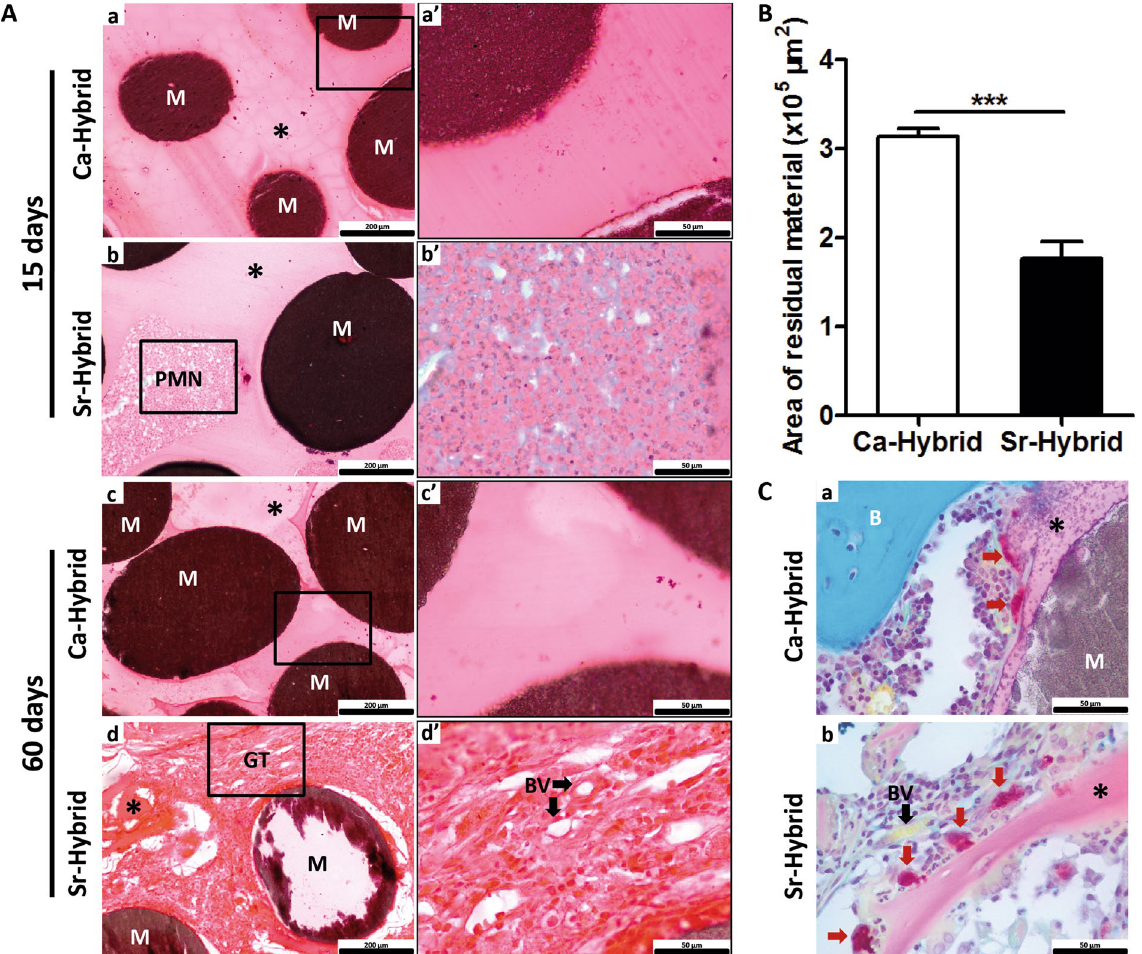
Figure 5. Histological analysis of the center of the defect in femurs implanted with Sr-hybrid and Ca-hybrid systems. Detailed view of the center of the defect implanted with Ca-hybrid (a and c) and Sr-hybrid (b and d) materials, stained with H&E, after 15 (a and b) and 60 days (c and d) of implantation, with higher magnification of rectangle (a’ to d’, A ). ( B ) Area of residual material (microspheres and alginate) found within the defect area, 60 days post-implantation of Sr-hybrid and Ca-hybrid systems. Measurements were performed by delimiting the area of material in MT stained sections using ImageJ software, n = 5 animals/group, 3 sections/animal. Data presented as mean ± SE and asterisks show statistically significant differences ( *** p < 0.001). ( C ) TRAP-LG staining images of Ca-hybrid (a) and Sr-hybrid (b) systems filled defects, 60 days post-implantation. (M – microspheres, * – alginate, PMN – Polymorphonuclear neutrophils, GT – Granulation Tissue, BV – blood vessels, red arrows –